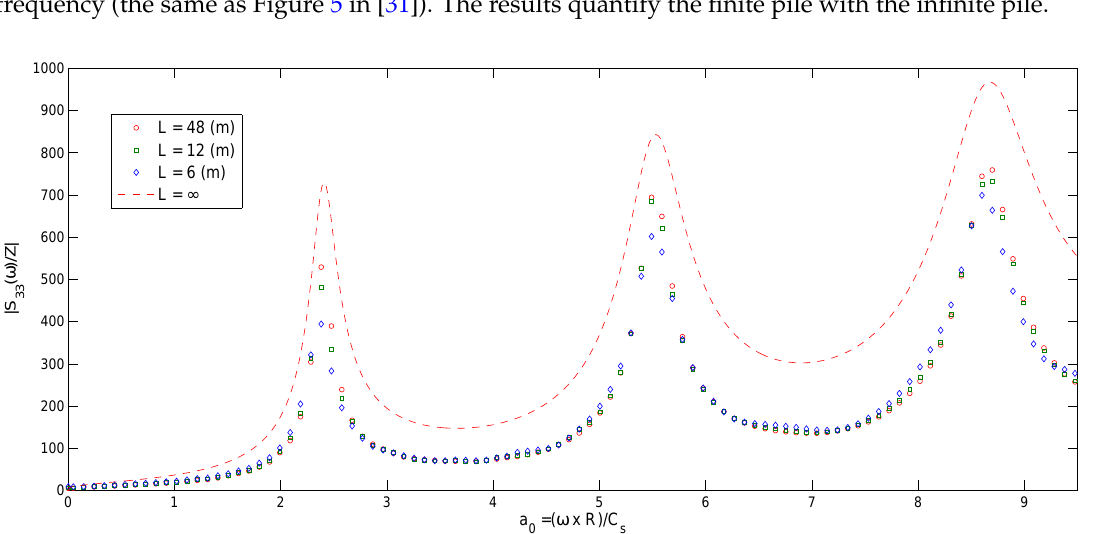
Figure 5. Comparison between dimensionless stiffness from the presented study and the results from boundary element method (BEM)/finite element method (FEM) in BEASTS by Andersen and Jones